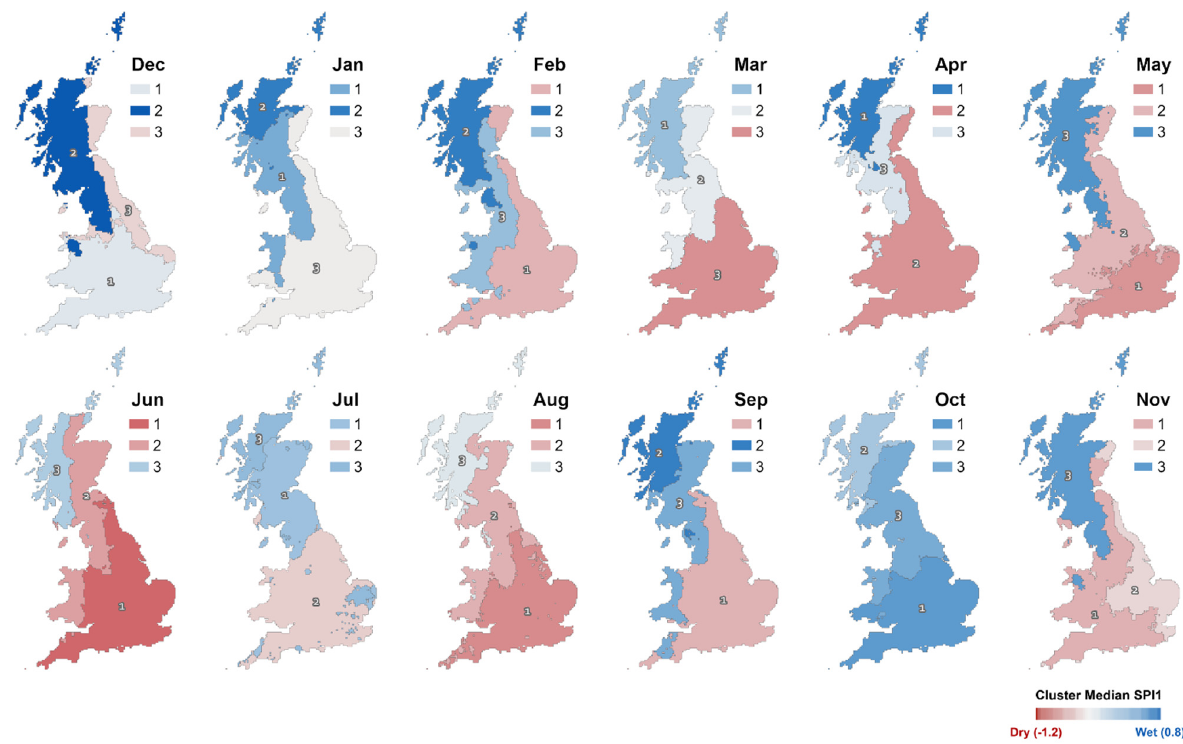
Figure 7. Monthly space-time clusters of SPI-1 values under NAO+ conditions. The clusters are coloured based on the median SPI-1 value of the cluster in space and time. Blue indicates a wetter median, whereas red indicates a drier median. Less saturated clusters indicate median SPI-1 values closer to 0.